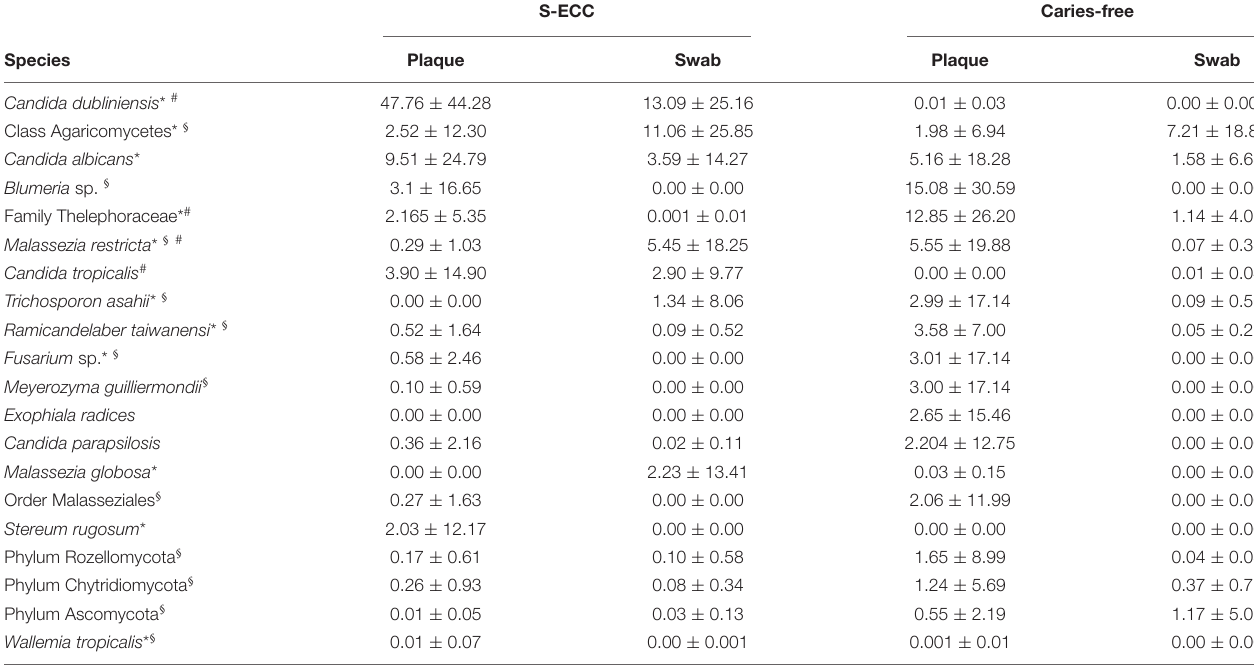
TABLE 2 | Mean relative abundance of the top 20 most abundant fungal